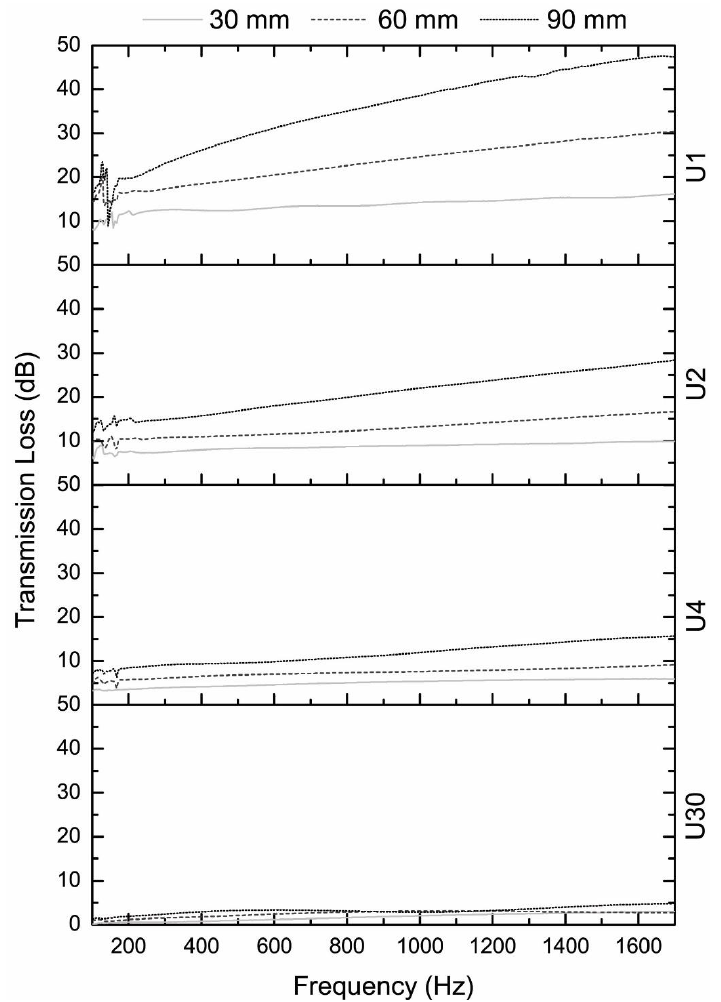
Figure 14. Transmission loss of the unbound samples. Energies 2016 , 9 , 619